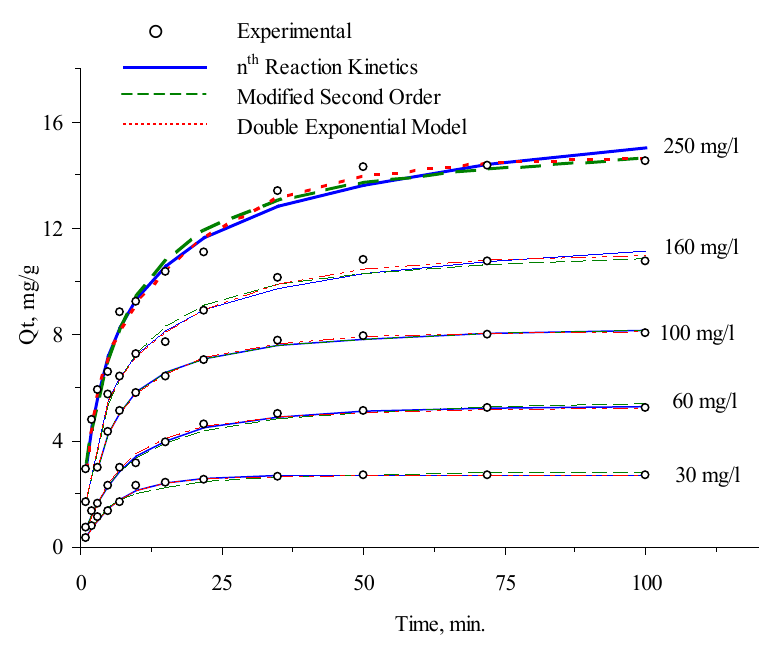
Figure 2. Comparison of adsorption kinetic models at 10 °C .